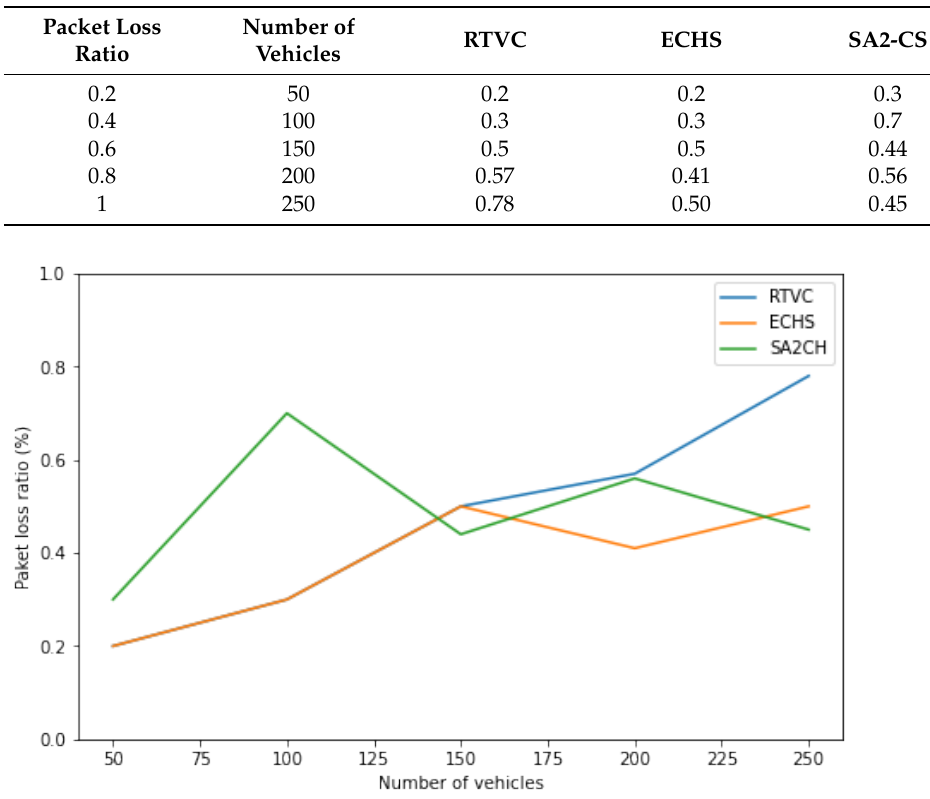
Figure 10. Comparative graph of PLR between the existing and proposed